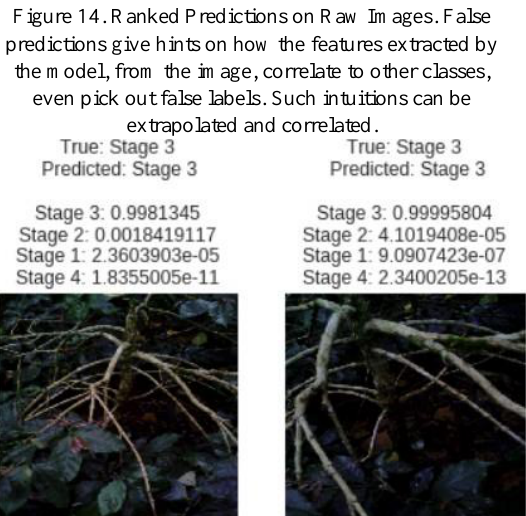
Figure 12. Accuracies of Transfer Learning on Processed images